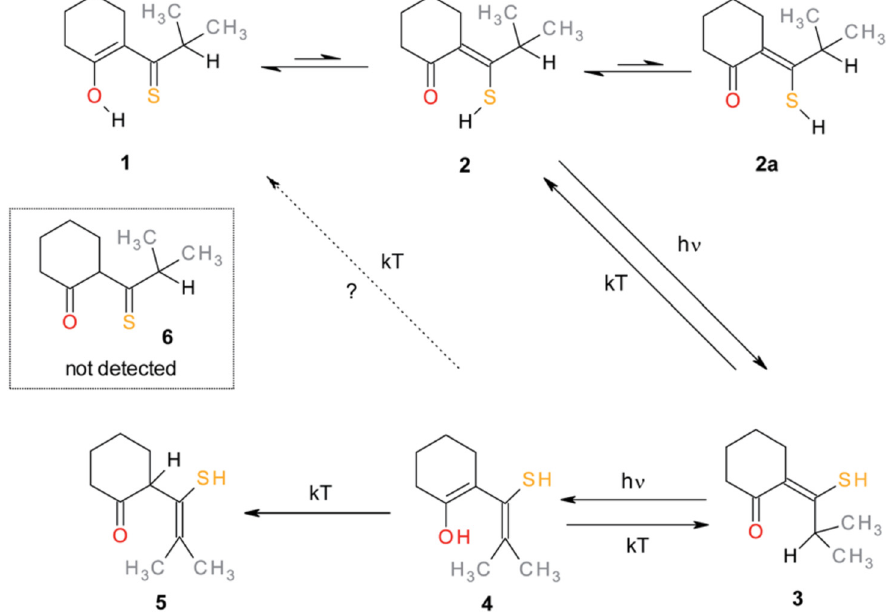
Hyphenated laser-NMR experiments of 5 in CD 2 Cl 2 at 203 K (irradiation 365 nm) led to the products seen in Scheme 7. Optimized lowest energy structures are seen in Scheme 8. Reaction products with water were also